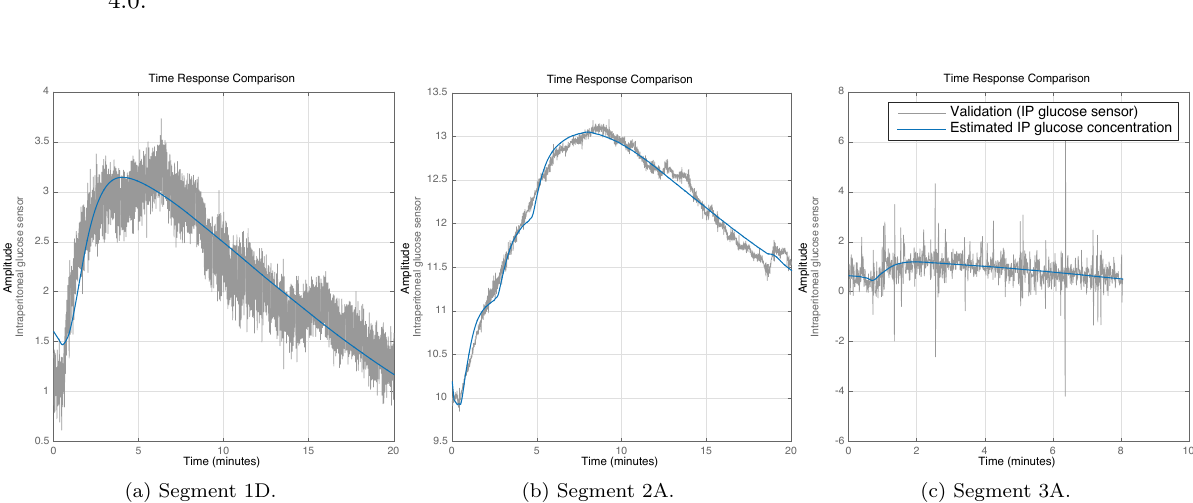
Figure 4: Examples of intraarterial (IA) and intraperitoneal (IP) sensor signals and corresponding IA and IP glucose concentration estimates for one segment of each animal experiment. Beware that the sensor signals are uncalibrated and thus have no unit. (*) The IA sensor type was 3ABP-beta in experiment 2 and 3ABP-alpha in experiments 1 and 3, as described in Section 2.2. Copyright: CC BY-NC-SA 4.0.